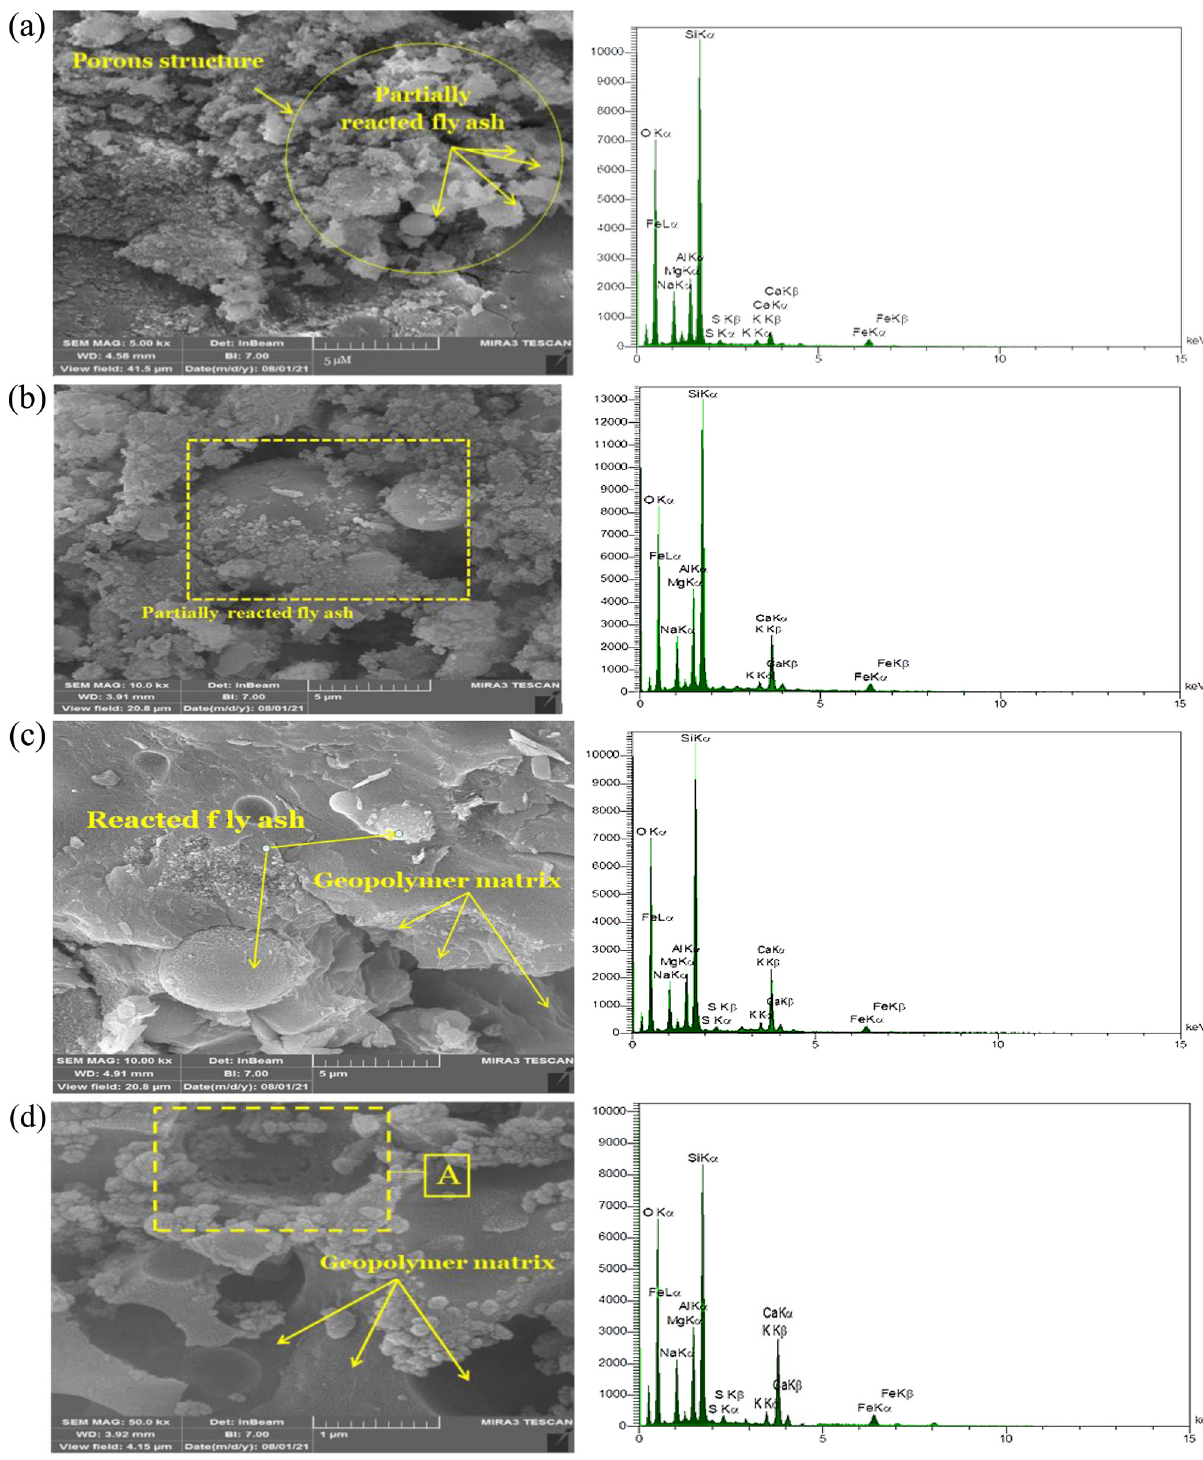
Figure 7: SEM - EDS result for soil - GP samples with di ff erent FA and AC ratios: ( a ) S - F10A0.4, ( b ) S - F20A0.4, ( c ) S - F15A0.6, and ( d ) S -